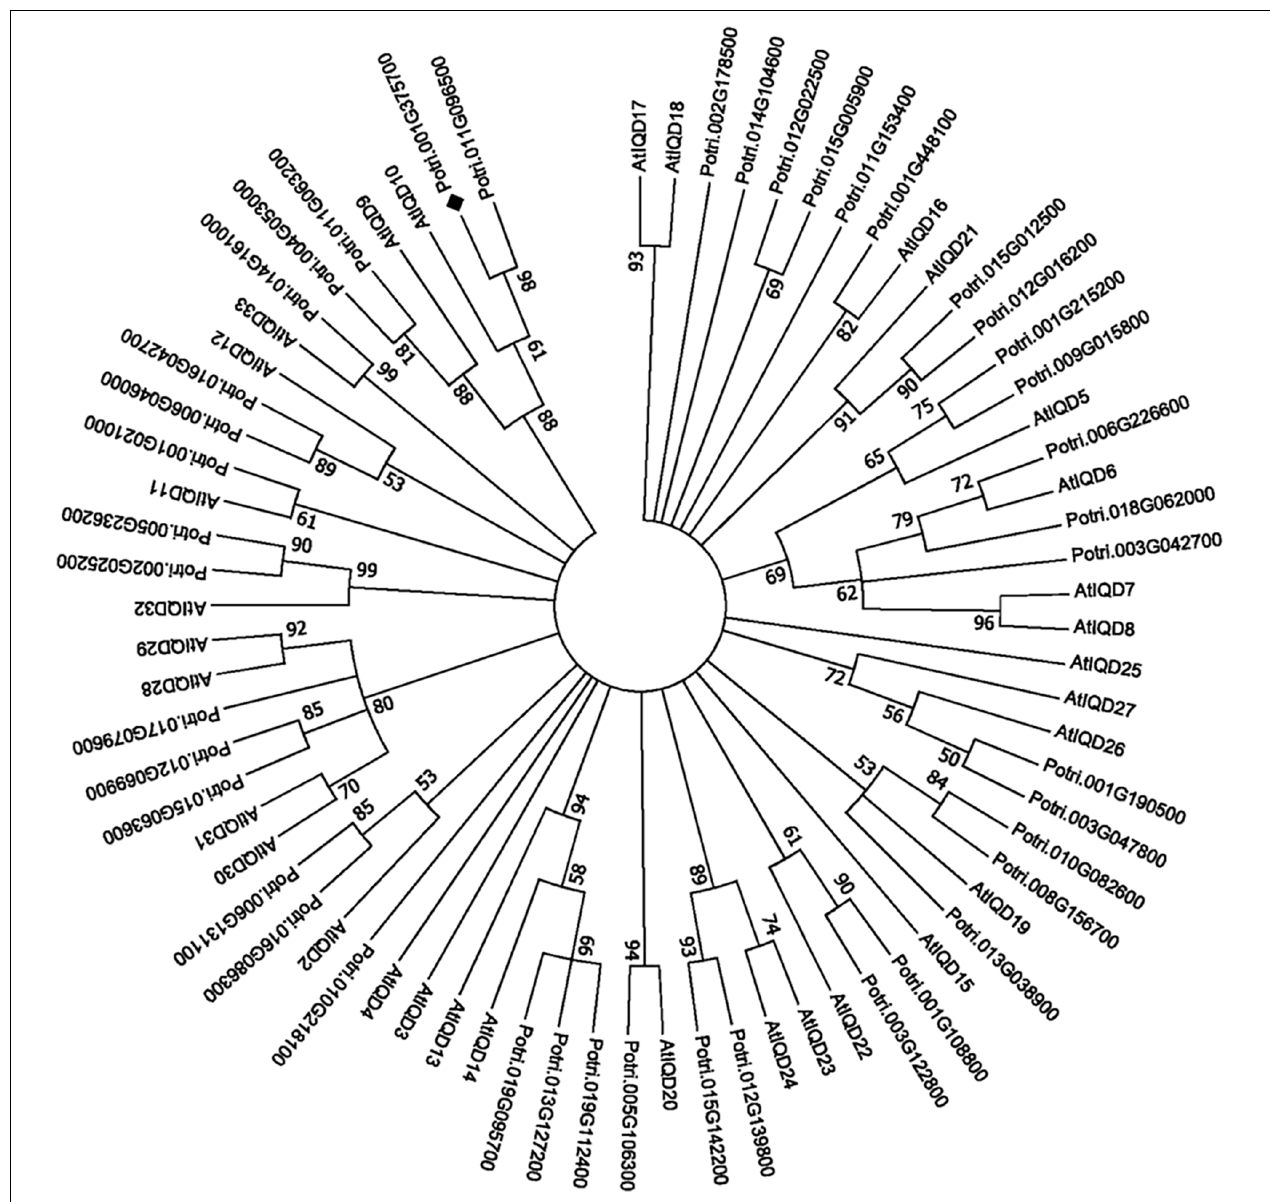
FIGURE 2 | Phylogenetic analysis of IQD gene family members from Populus and Arabidopsis . The predicted IQD protein sequences from Populus and Arabidopsis were used to generate the phylogenetic distance tree. The tree was generated using Maximum Likelihood algorithm in MEGA7.0.25 with 1000 bootstrap replicates and represents 42 Populus and 33 Arabidopsis IQD members. The target of this study, PdIQD10 (Potri.001G375700), is marked “ (cid:7)